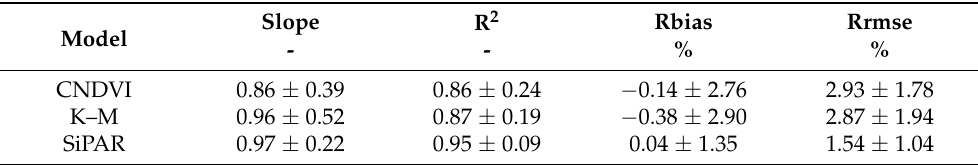
Figure 9. The spatial distribution of sugarcane yields in different years and the prediction perfor- mances of the CNDVI, K–M, and SiPAR models in Palm Beach County. Table 2. The validation results of the CNDVI, K–M, and SiPAR models during cross-validation using the data in Palm Beach